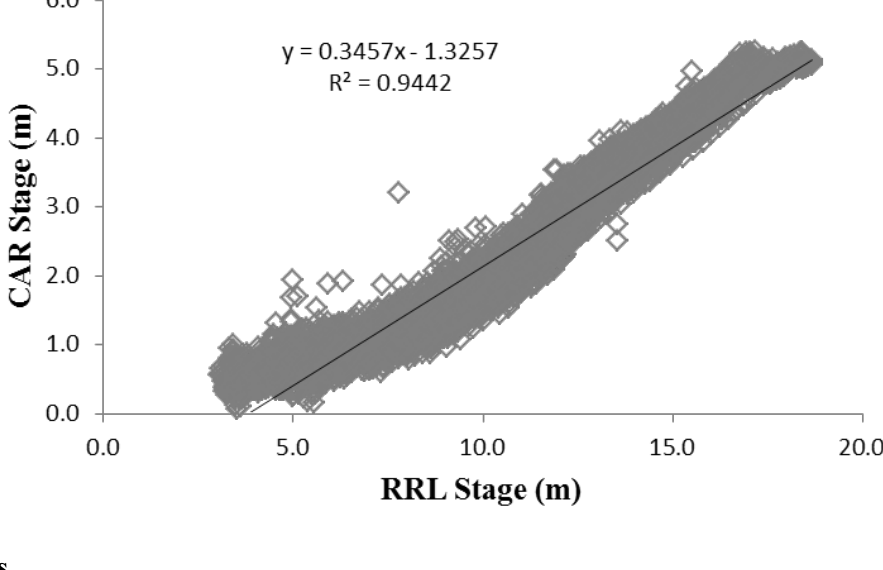
Figure 6. Relationship of the river stage between Red River Landing (RRL, river mile 302.4) and Carrolton, New Orleans (CAR, river mile 102.8), from 1980 to 2010. A two-day lag was used to account for the distance between